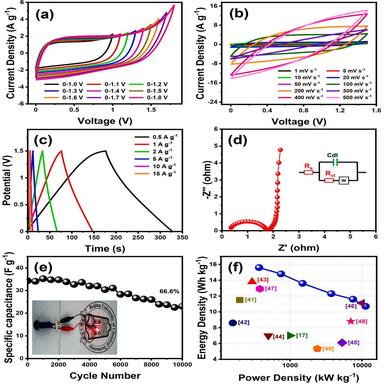
Electrochemical performances of assembled symmetrical supercapacitor based on SAPC electrode, (a) CV curves of at different potential windows, (b) CV curves at different scan rates, (c) GCD plots at different current densities, (d) Nyquist plot and equivalent circuit diagram, (e) GCD cyclic test at 15 A g− 1 (insert: powered red LED lamp) and (f) Ragone plots.